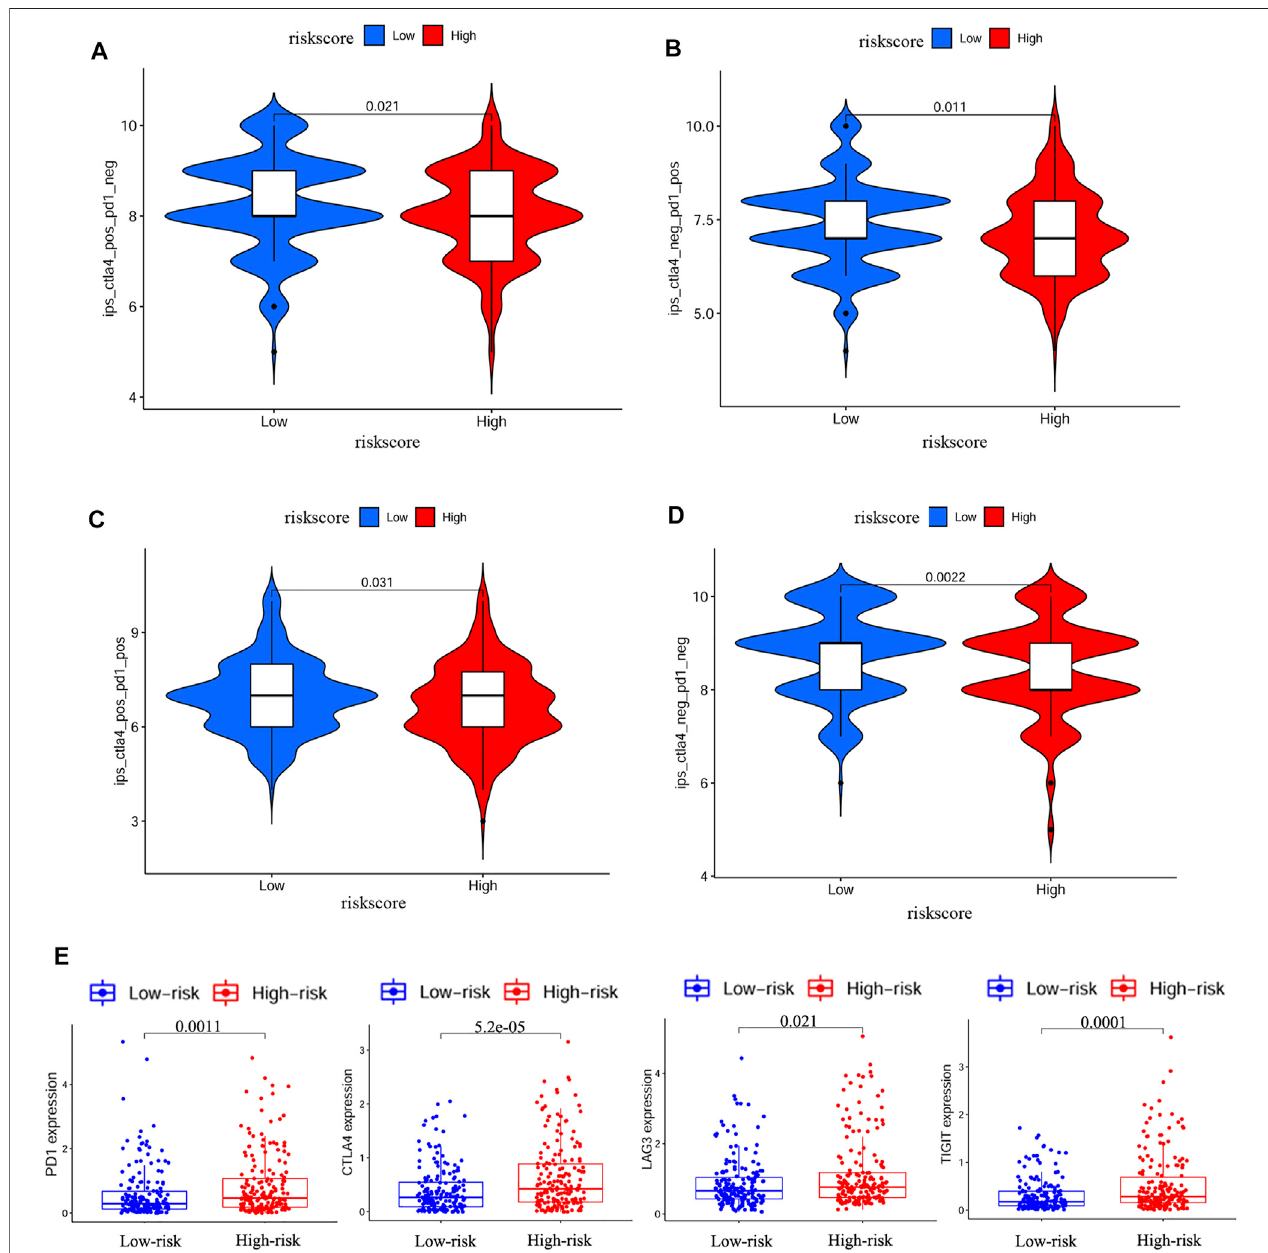
FIGURE8 | IPS analysisand correlationsbetween risk scoreand common immunecheckpoints (A – D) Comparison ofthe scores ofIPS-CTLA4 blocker, IPS-PD1 blocker, IPS-PD1/CTLA4 blocker and IPS between different risk groups (E) Correlations between risk score and PD1, CTLA4, LAG3 and TIGIT.